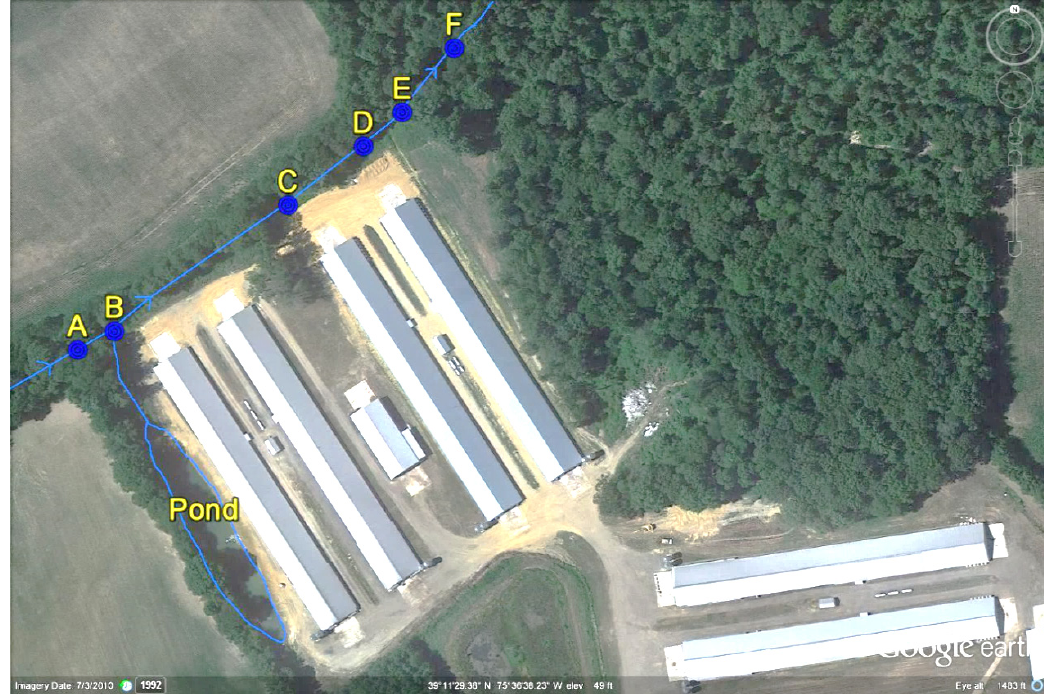
Figure 3. Aerial view showing the water sampling points in the poultry farm. Letters in figure denotes sampling locations. Please see table 1 for the specific sites descriptions.